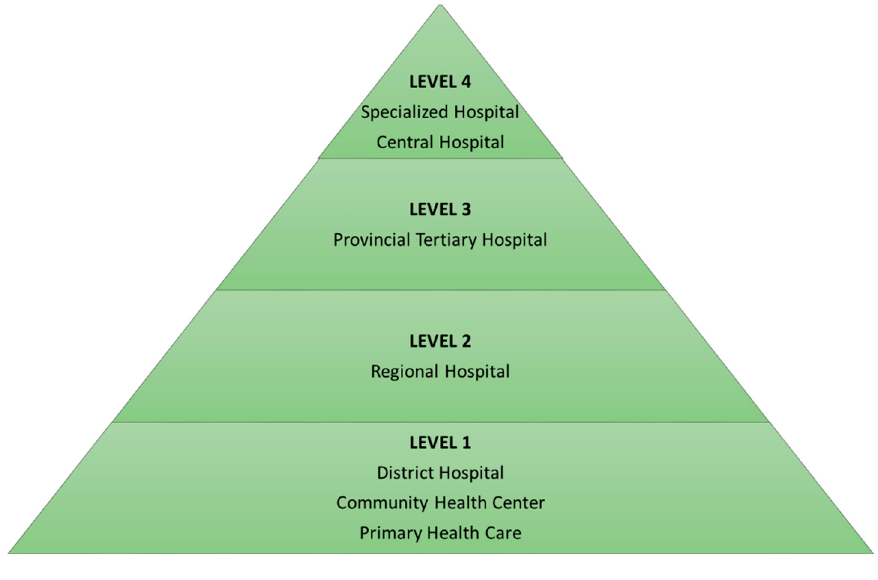
Figure 2. Levels of healthcare in South Africa [66].